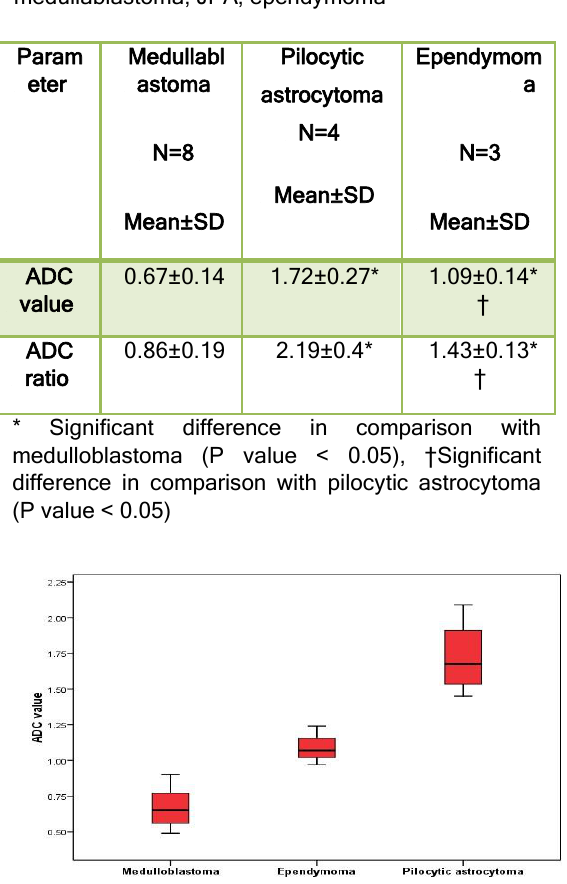
Table (3 ): ADC value and ADC ratio of